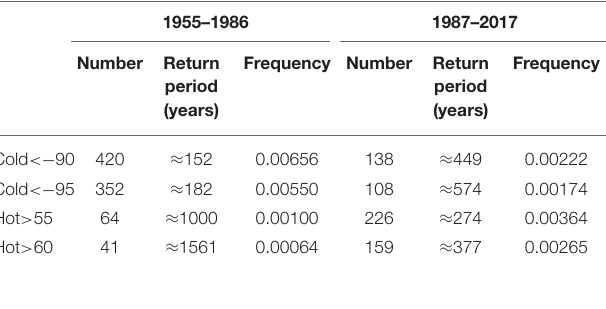
TABLE 5 | Validation of the maximum number (nb) and maximum intensity (int) of heat and cold waves (number of years with higher numbers of events than the 90% Confidence Interval upper bound: nb > q95 and number of years with cold events with an intensity lower than the 90% CI lower bound: int < q5 or hot events with an intensity higher than the 90% CI upper bound: int > q95) and frequency of intense (int < − 90 for cold waves, int > 55 for heat waves) and very severe events (int < − 95 for cold waves and int > 60 for heat waves) in periods 1955–1986 and 1987–2017 according to different sensitivity tests. BNU-ESM, IPSL-CM5-MR, MIROC5, MPI-ESM-MR BCC-CSM1.1, CanESM2, CCSM4, EC-EARTH Smoothing param.: